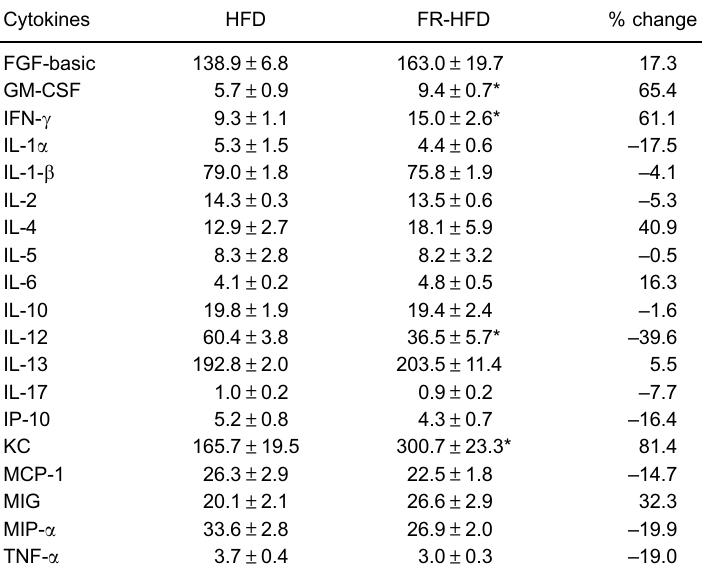
Table 1. Serum levels of cytokines (pg/mL) in freely fed high-fat diet (HFD) or food restricted high-fat diet (FR-HFD) mice for 56